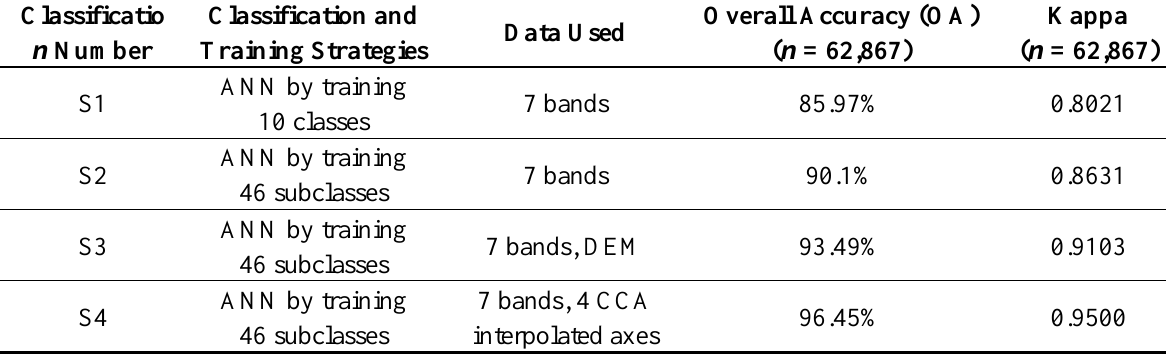
Table 11. Summary of the TM image (1 March 2004) classification results in the southern study area.